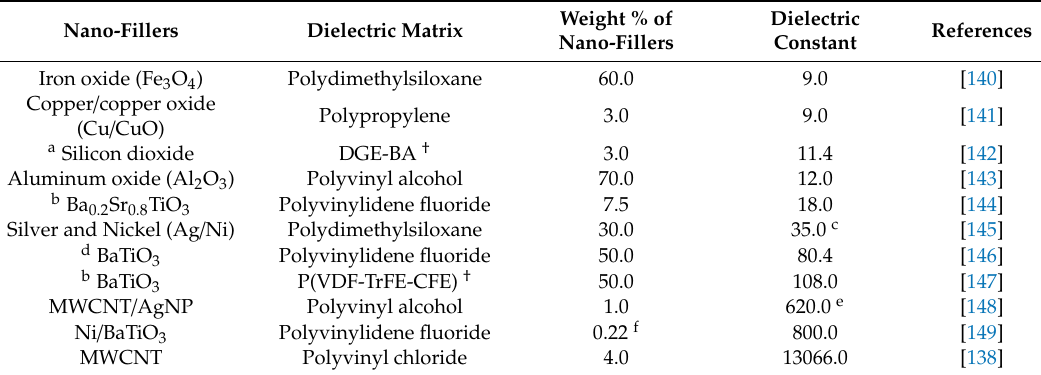
Table 3. Dielectric constant of some selected